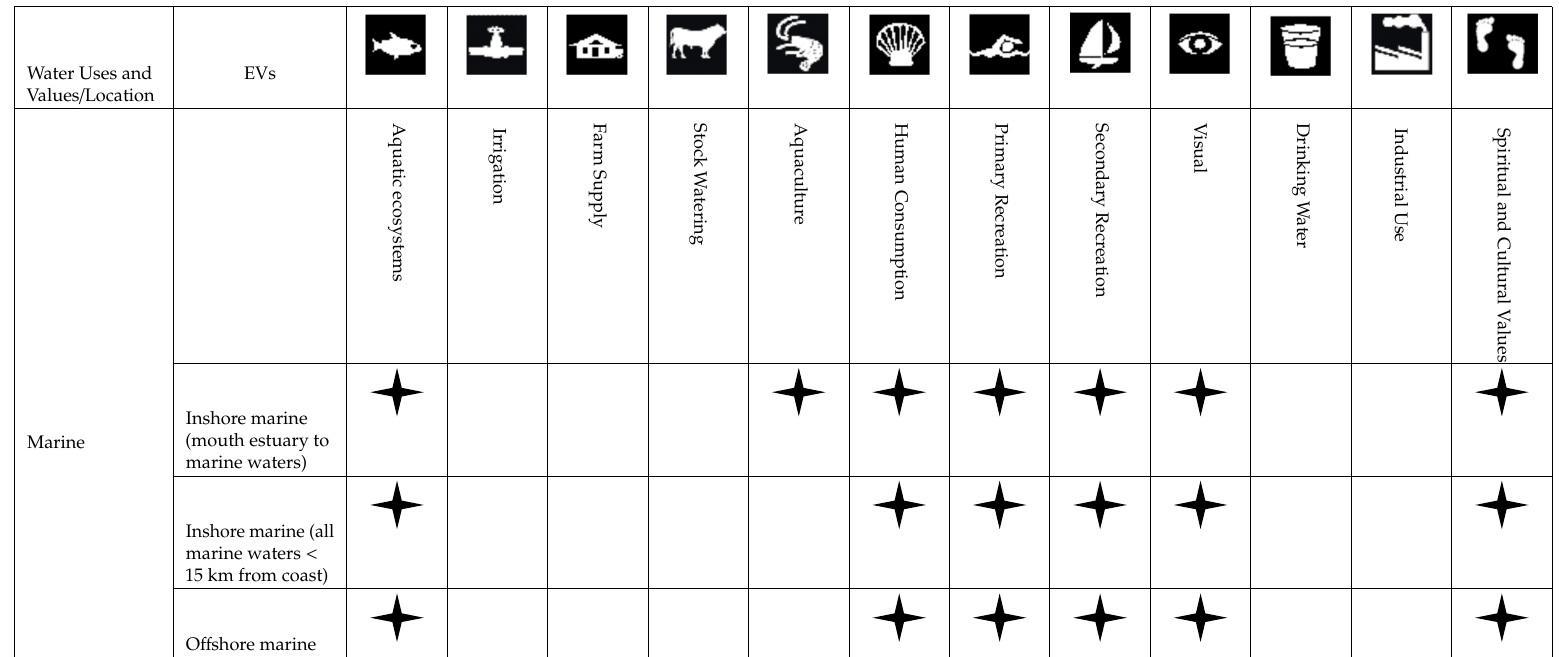
Table A3. List of EVs * Summarised for the Tully Basin EVs (as a result of this current research. Table A1. List of EVs * Summarised for the Tully Basin EVs (as a result of this current research. Table A1. List of EVs * Summarised for the Tully Basin EVs (as a result of this current research. Table A1. List of EVs * Summarised for the Tully Basin EVs (as a result of this current research. Table A1. List of EVs * Summarised for the Tully Basin EVs (as a result of this current research. Table A1. List of EVs * Summarised for the Tully Basin EVs (as a result of this current research.